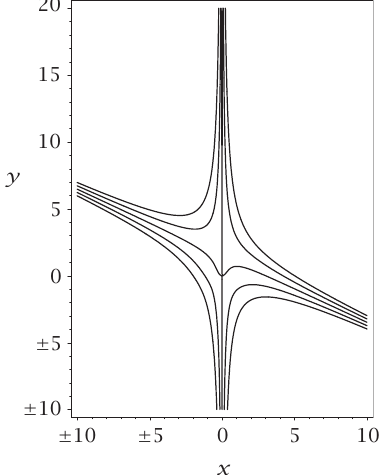
Figure 3.4 . Streamline pattern for x 2 − 3 x + 2 xy + tan − 1 (y/x)x = constant.